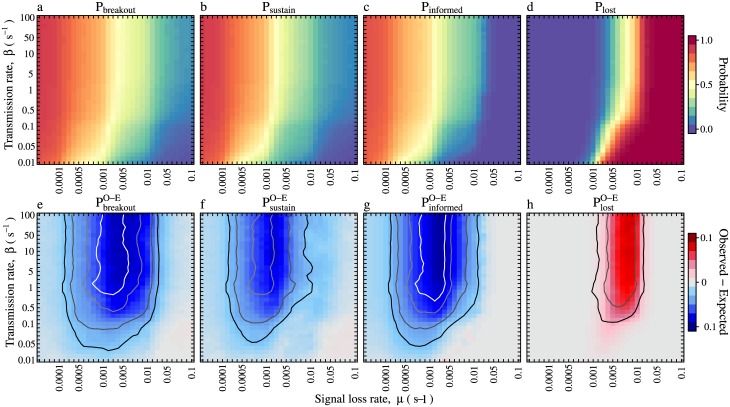
Parameter space explorations show transmission inhibition.a-d Parameter space exploration produced by running the UIU model upon the observed contact networks across a range of signal transmission and loss rates. e-h Signed difference between transmission over the original time-ordered contact networks (observed) and the synthetic aperiodic networks produced by the null model (expected). (a,e) The probability that the information spreads further than the initial seed. (b,f) The probability that the information reaches the steady state, and hence becomes self-sustianing. (c,g) The size of the steady state population of informed ants, expressed as a proportion of the entire colony. (d,h) The probability that the informed population declines to zero. Each {β, μ} point in the parameter space represents an average across the 15 networks. All contact networks were constructed using the most conservative contact definition, θ≥120°. Contours indicate the number of networks for which the observed-expected difference was statistically significant (at p≤0.05). Black contour; ≥3 networks significant. Dark grey; ≥6 significant. Light grey; ≥9 significant. White≥12 significant.